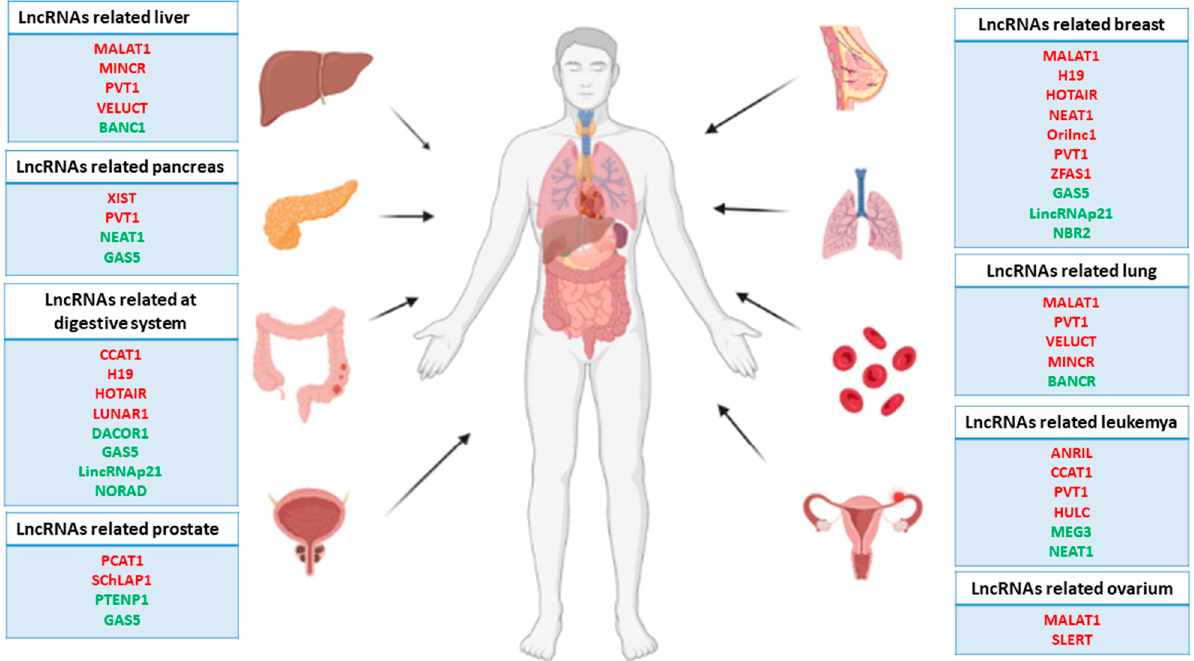
Figure 1. Representative scheme of the main human carcinomas and related lncRNAs. Note that the red lncRNAs act as oncogenes, while the green lncRNAs act as tumor suppressor genes. Cancer’s underlying epigenetics has been widely studied, given its pivotal role in the initiation, progression, and metastasis of most types of cancer, as well as its potential as a target for different gene therapies [35–37]. Epigenetics can be defined as the set of modifications that alters the structure or state of chromatin, differentially regulating its gene expression without changes in the DNA sequence [38]. Epigenetic alterations can be included in two basic groups. The first is modifications in the DNA, basically produced by the addition of methyl groups at the 5 ′ end of certain cytosines located in the so-called CpG islands, where long stretches of CG dinucleotides harbor the promoter regions of the genome that present high, precise, and intense gene regulation [39]. Methylation of the cytosines prevents binding of the transcription factors to the promoter regions, which results in gene repression. Interestingly, many types of cancer display a specific pattern of hyper-methylated CpG islands in several tumor suppressor gene promotors, inhibiting their expression and leading to an increase in different subpopulation cancer cells and thus enhanced tumor development [40–42]. The second group is modifications in the histone tail, essentially caused by methylation, acetylation, or phosphorylation of certain lysines located in the N-terminal region of histones 3 ′ , altering the nucleosome charge, affecting the chromatin state, and thus allowing or preventing the recruitment of transcriptional co-activators to it [43]. These modifications are carried out by chromatin remodeling complexes that add open or close marks to the genome, making it accessible to the transcriptional machinery [44]. Unlike the hyper-methylation of the CpG islands, in many types of cancer, hypo-methylation of the genome is observed, leading to ectopic activation of specific oncogenes, whose expression is inhibited in homeostatic conditions. Ectopic activation of these oncogenes is essential for the cell to acquire an oncogenic phenotype and escape from cellular control systems [45,46]. In the same way, some of these chromatin remodeling complexes show enhanced or reduced activity in malignant cells, which leads to dysregulation in the chromatic structure, promoting the expression of genes that enhance tumor development